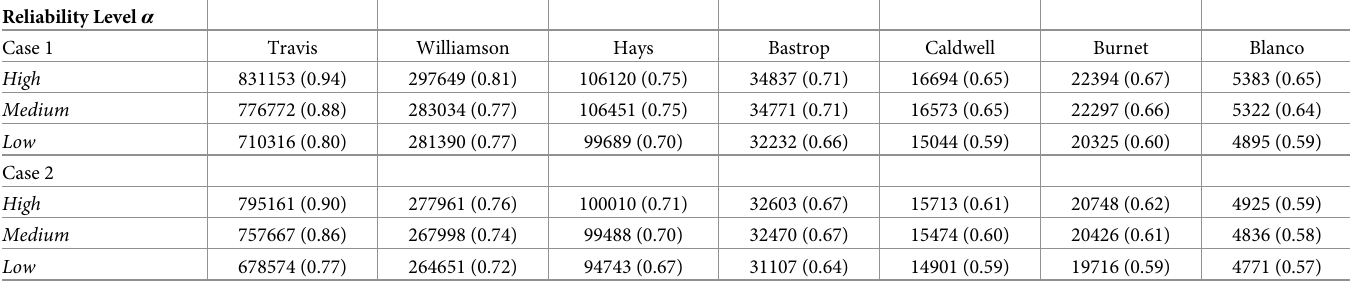
Table 8. The minimum number of vaccinations required to bring R the population to be vaccinated is in parentheses. Reliability Level